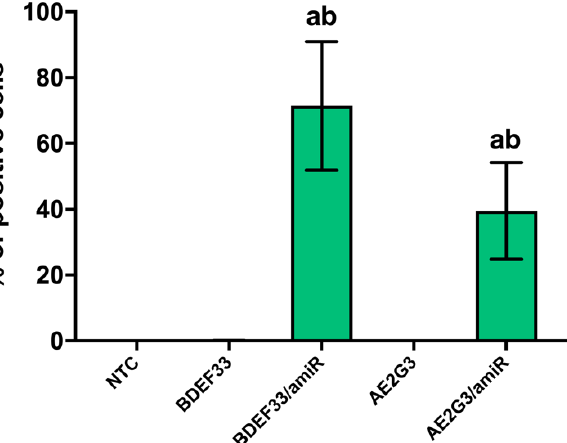
Figure 2. Evaluation of internalization of dendriplexes containing fluorescent-labeled RNA (amiR- 155-FAM) into PBMCs ( n = 3) after 4 h of treatment. Mann – Whitney test was used. Letter “a” marks significant differences ( p < 0 .05) in comparison with NTC, “b” marks significant diffe rences in com- parison with a free